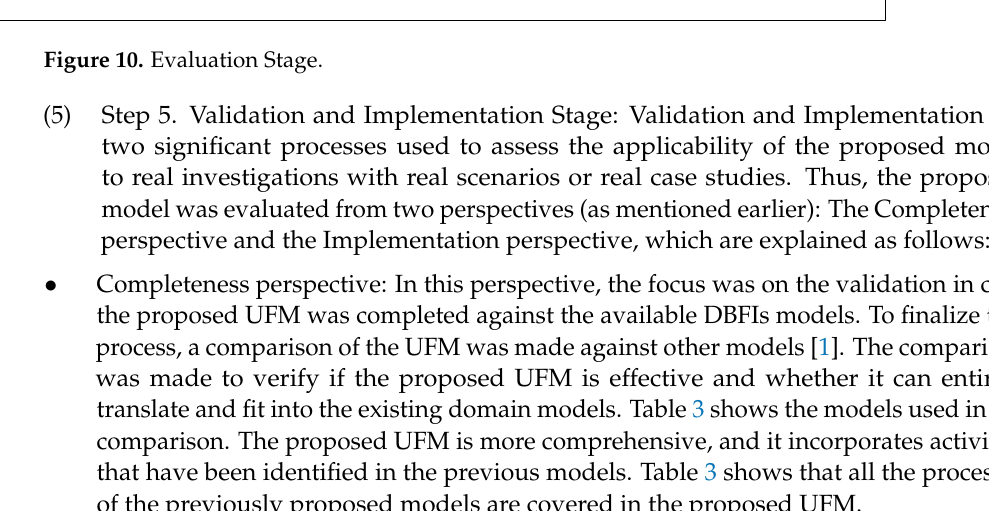
Table 3. Comparison between exiting DBFI models with the proposed model.